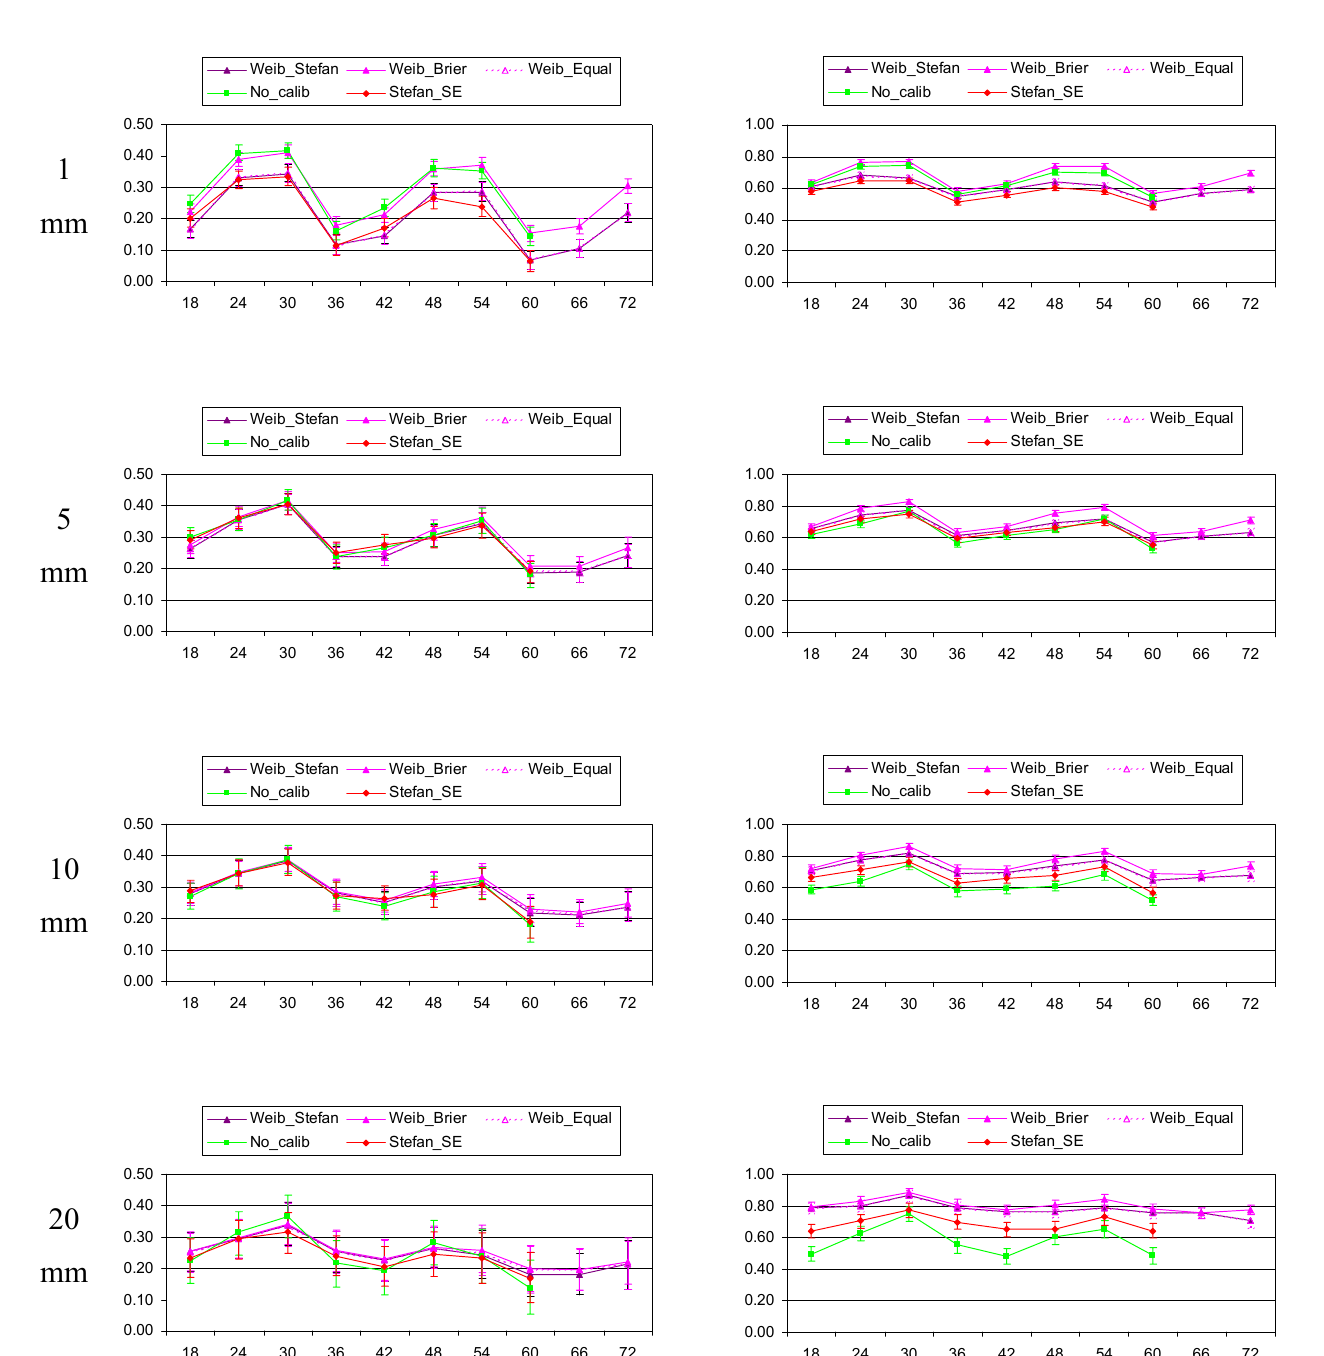
Fig. 5. Comparison of the Brier Skill Score (left-side panels) and the ROC Area Skill Score (right-side panels) results for the maximum precipitation values, calculated using the 1-, 5- and 10- and 20-mm thresholds, for the different ensembles: the Weibull-based approach with the Stefanova weights (purple line), the Brier score-based weights (pink line) and the equal weights (pink dashed line); the not-calibrated ensemble (green line); and the Stefanova ensemble (red